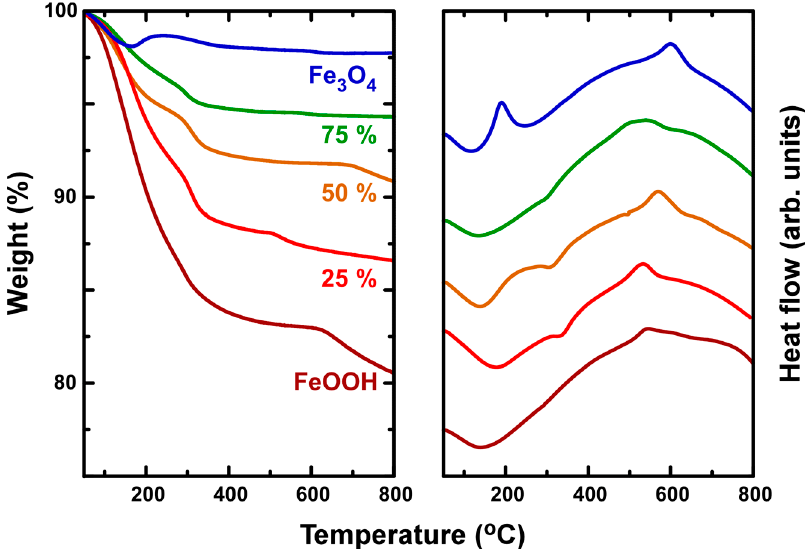
Figure 3. Thermogravimetric and differential thermal analysis for studied Fe 3 O 4 /FeOOH nanocomposites.